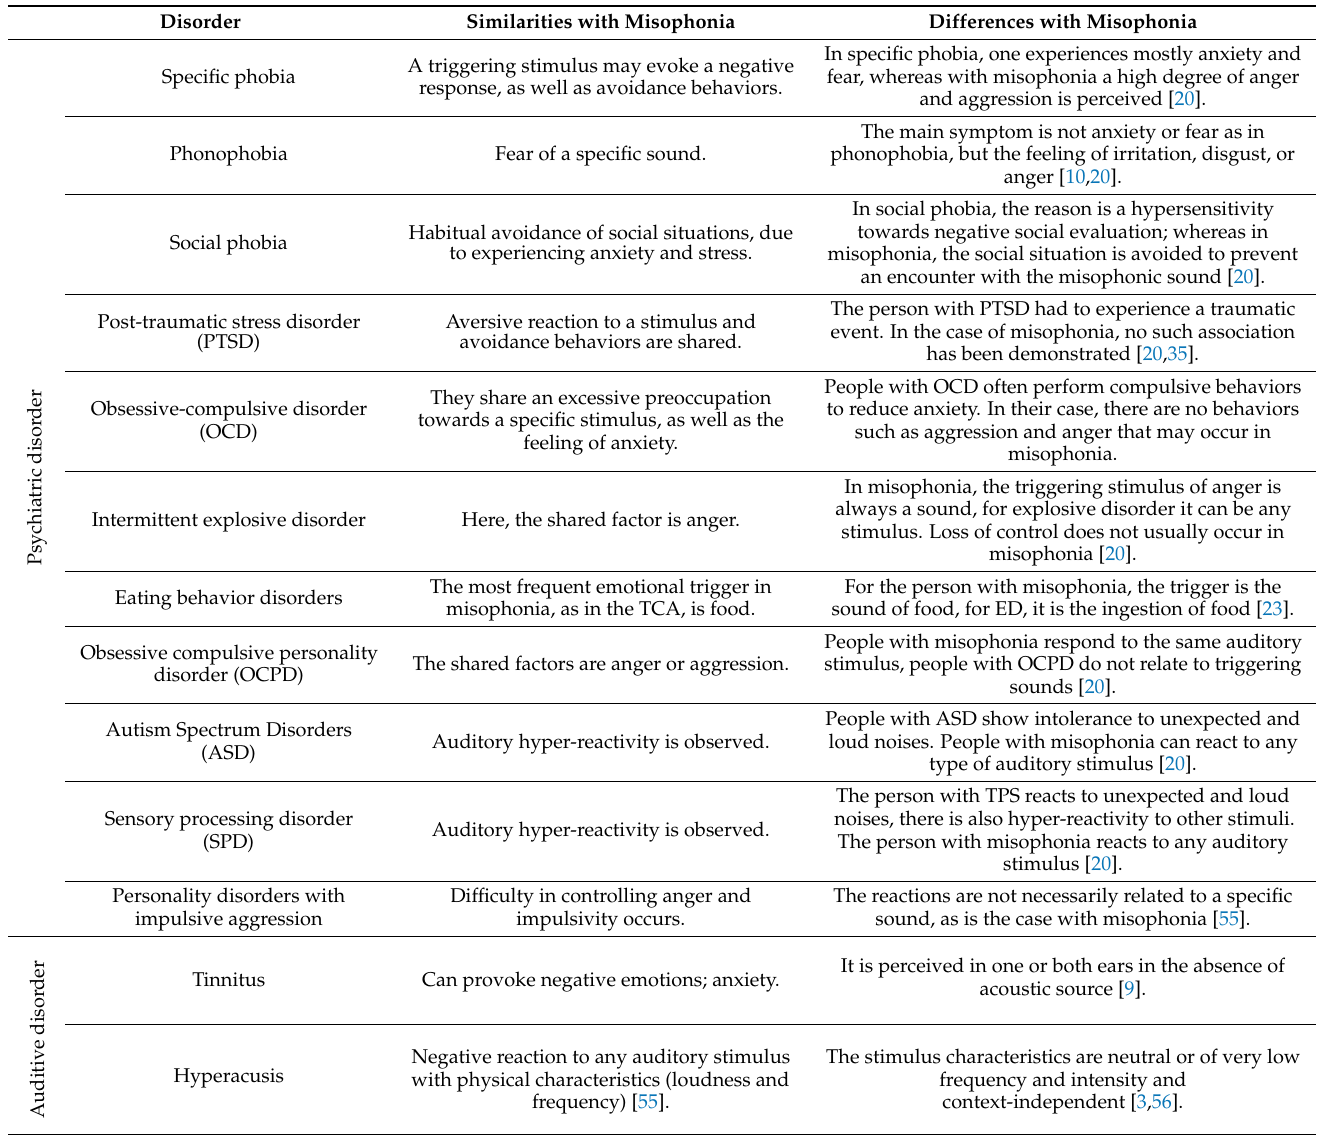
Table 1. Disorders most frequently involved in the differential diagnosis of